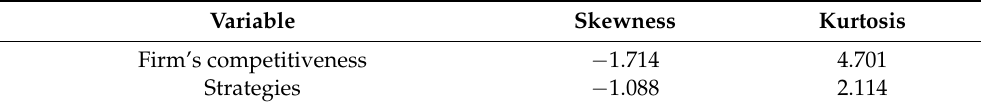
Table 8. Skewness and kurtosis